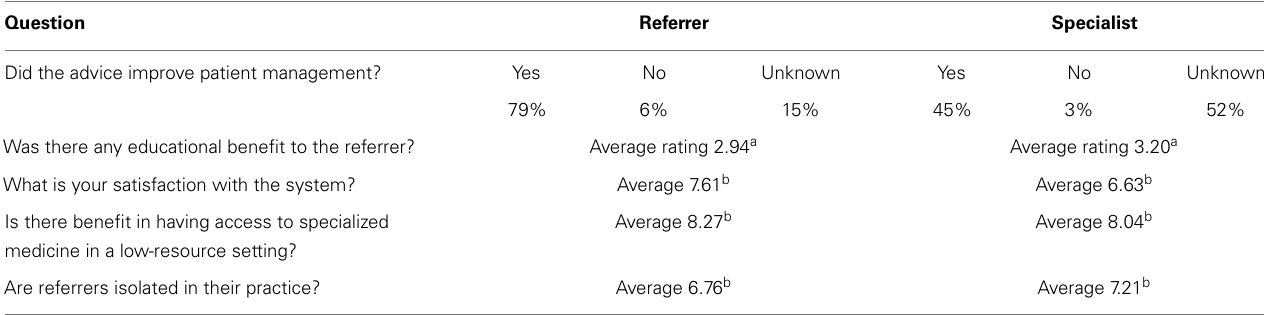
Table 4 | Comparison of referrer and specialist opinions about the benefits and satisfaction with the system .